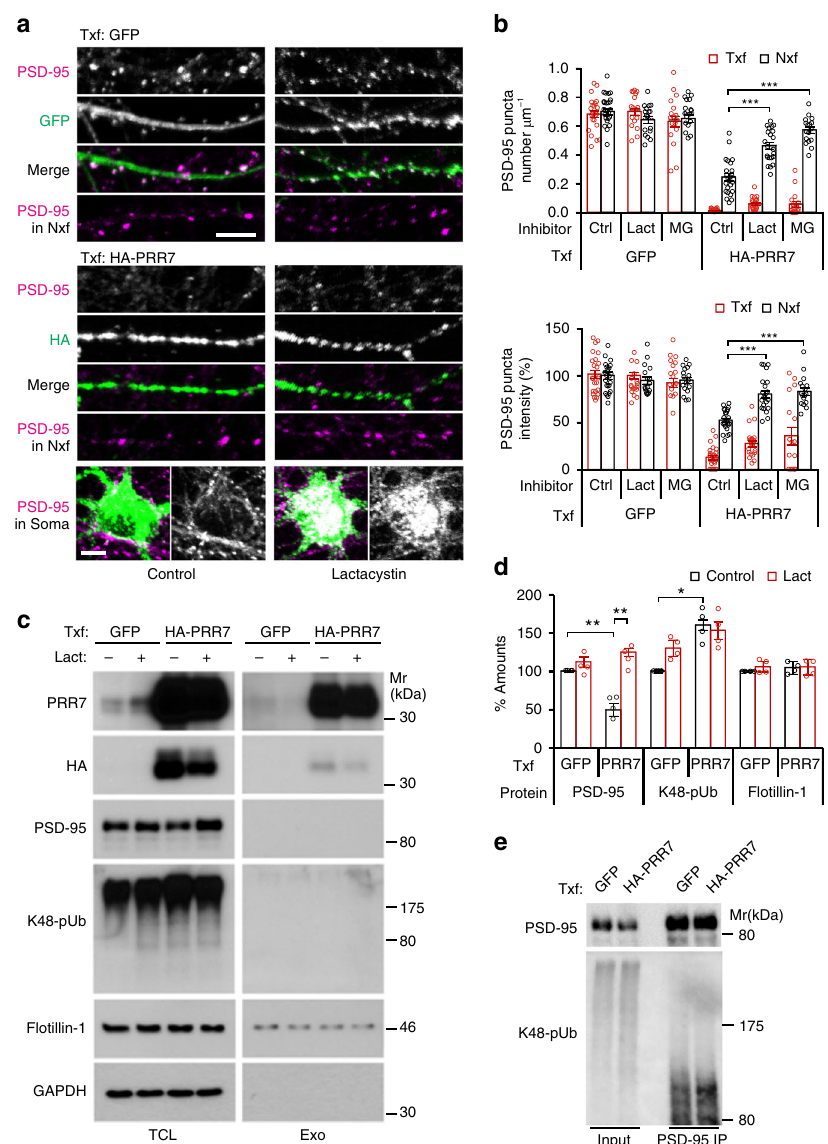
Fig. 7 PRR7 promotes the proteasomal degradation of synaptic proteins. a , b Effect of proteasome inhibitors on PRR7-induced removal of PSD-95 clusters. Representative immuno fl uorescent images of PSD-95 in the dendrites and soma (Lactacystin-treated) from GFP-transfected or HA-PRR7-transfected neurons ( a ), and quantitation of data ( b ). Scale bars, 5 μ m. Lact lactacystin, MG MG132-treated neurons. n = 17 – 24. c , d Effect of PRR7 overexpression on the protein levels of major PSD scaffold proteins and poly-ubiquitination (pUb), in the absence (control) or presence of Lact. Representative immunoblots of TCL and puri fi ed exosomes from the CS ( c ) and quanti fi ed data for the protein levels in TCL ( d ). n = 4. e Increased poly-ubiquitination of PSD-95 by PRR7 overexpression. IP immunoprecipitation, Mr relative molecular weights. Two-way ANOVA, post hoc Tukey ’ s test: F 5,230 = 222.3 ( b , density), F 5,230 = 98.42 ( b , intensity), F 1,12 = 7.098 ( d , PSD-95), and F 1,12 = 23.87 ( d , K48-pUb). *** P < 0.0001, ** P < 0.01, and * P < 0.05. Data are mean ±